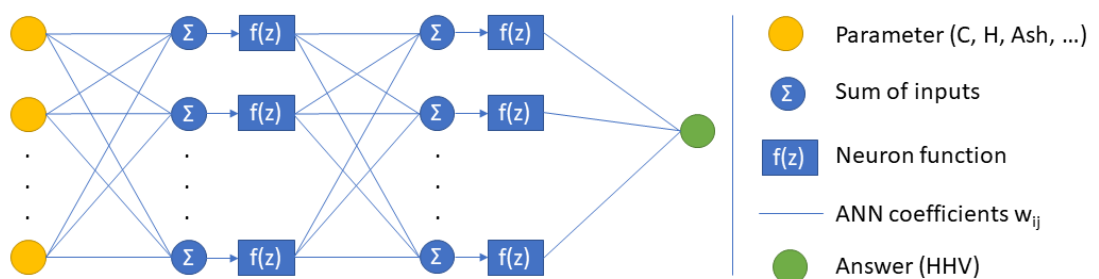
Figure 1. The schematic diagram for MLP-ANN.